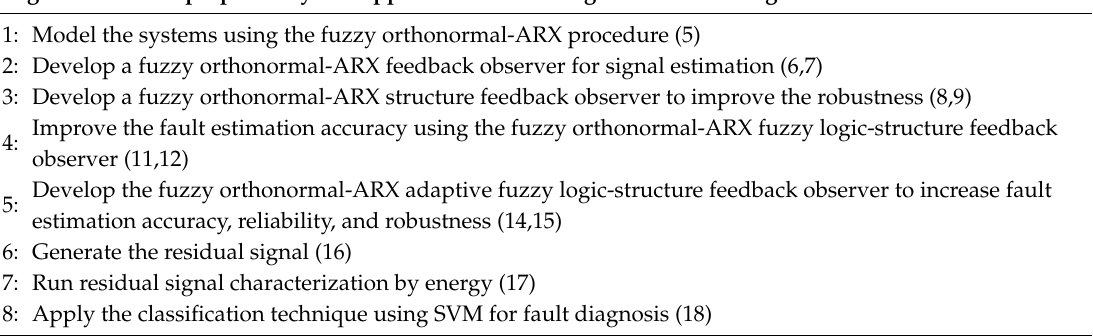
Algorithm 1. The proposed hybrid approach for fault diagnosis in a bearing.